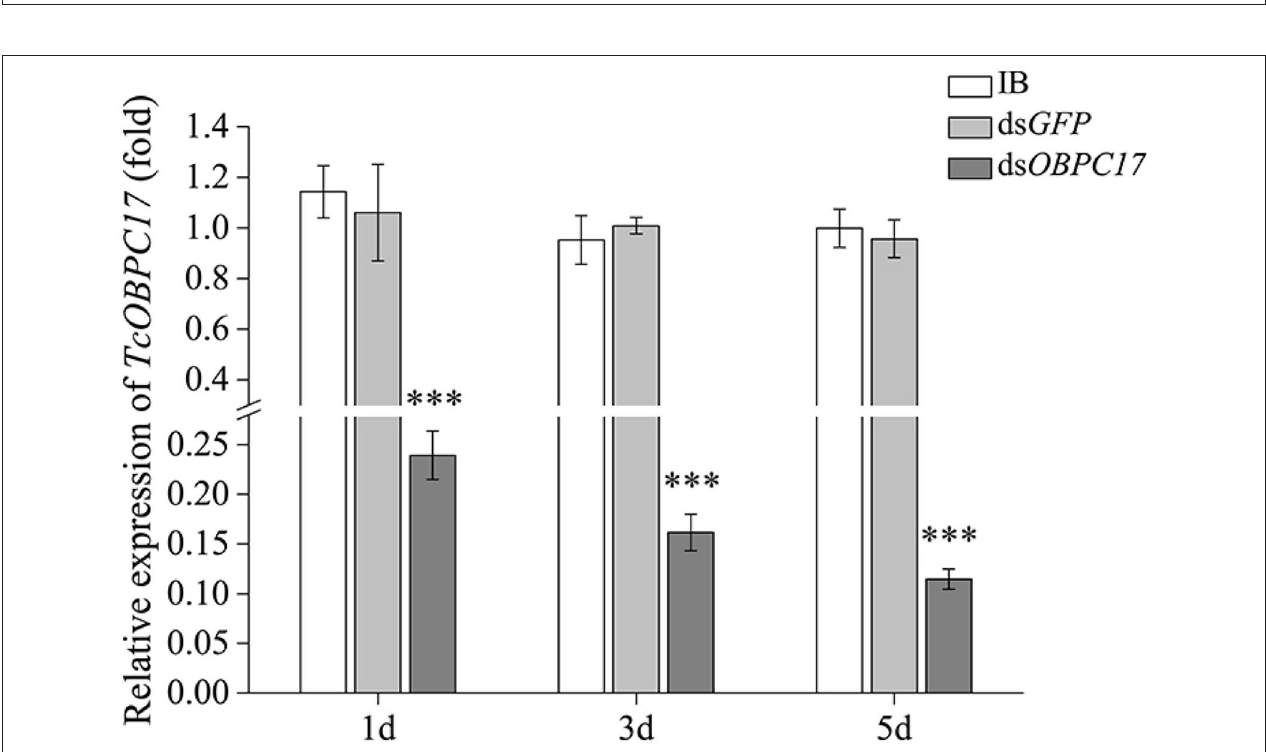
FIGURE 3 | Relative expression level of TcOBPC17 after exposure to A. vulgaris EO or acetone. TcOBPC17 was measured 12, 24, 36, 48, 60, and 72h after treatment with 5% A. vulgaris EO or acetone. The results are presented as means ± SE ( n = 3). Student’s t- test was employed to perform significant difference analysis (** P < 0.01, *** P < 0.001).